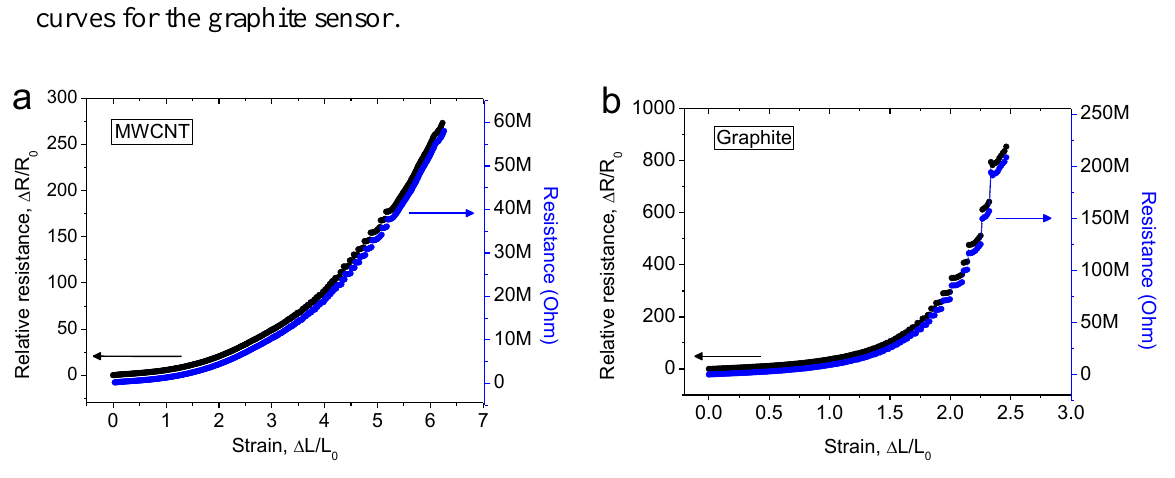
Figure 3. Response curves: ( a ) Relative resistance and resistance versus strain response curves for the MWCNT sensor; ( b ) Relative resistance and resistance versus strain response curves for the graphite